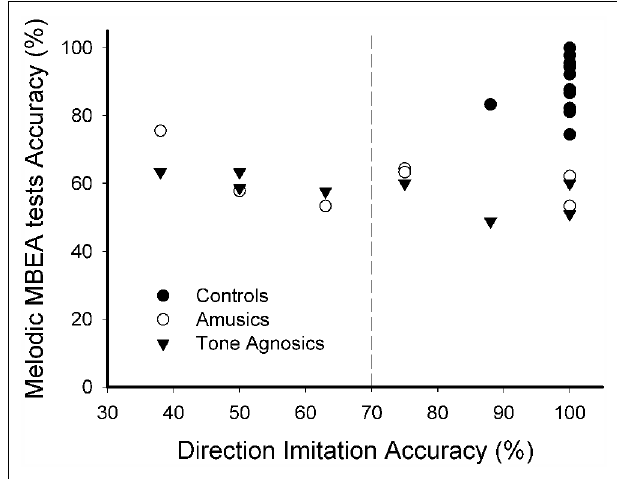
FIGURE 3 | Direction accuracy of three-note imitation across the three groups. A dashed line divides two distinct groups based on individual performances on direction accuracy of three-note imitation for the controls, the amusic, and tone agnosic